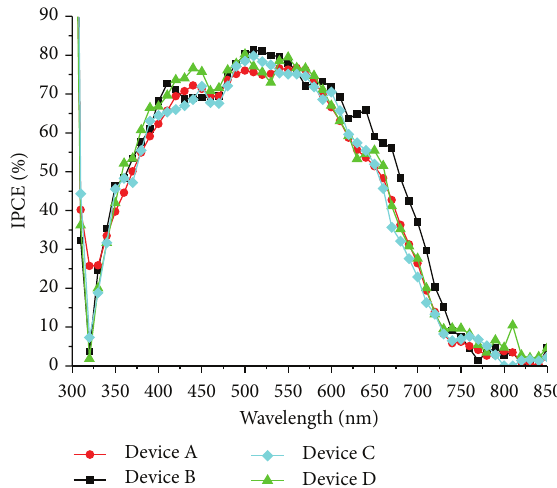
Figure 4: IPCE action spectra of solar cells sensitized by N719 (Device A), N719:4L (1: 0.25) (Device B), N719:4L (1: 0.5) (Device C), and N719: 4L (1:1) (Device D) with 12.0 + 4.0 𝜇 m double layers nanocrystalline TiO 2